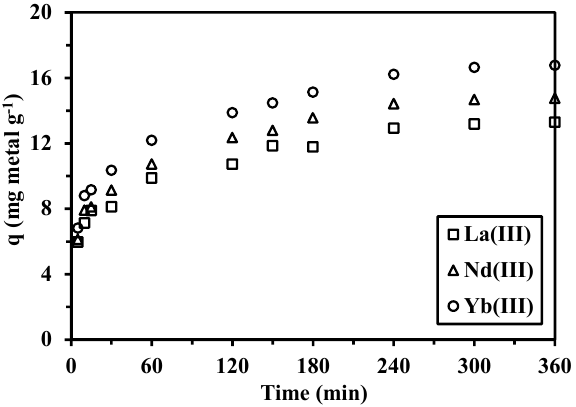
Figure 7. Effect of contact time on the adsorption of La(III), Nd(III) and Yb(III) ions ( C i = 100 mg·L − 1 ; T = 300 K; pH = 5; m = 0.05 g; V = 100